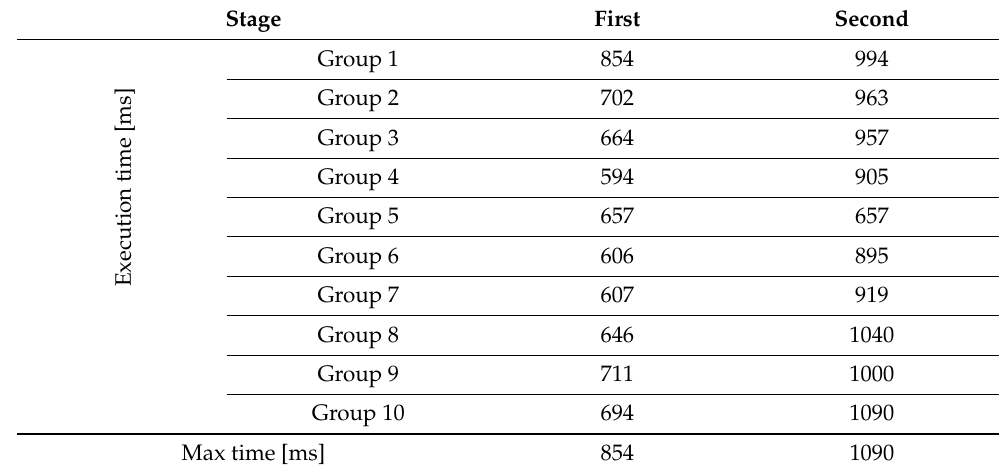
Table 5. Computing time to perform the first and second stages.